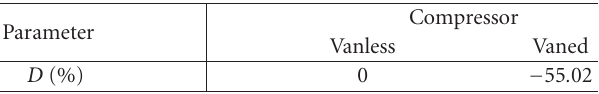
Table 1: Unsteadiness degree of